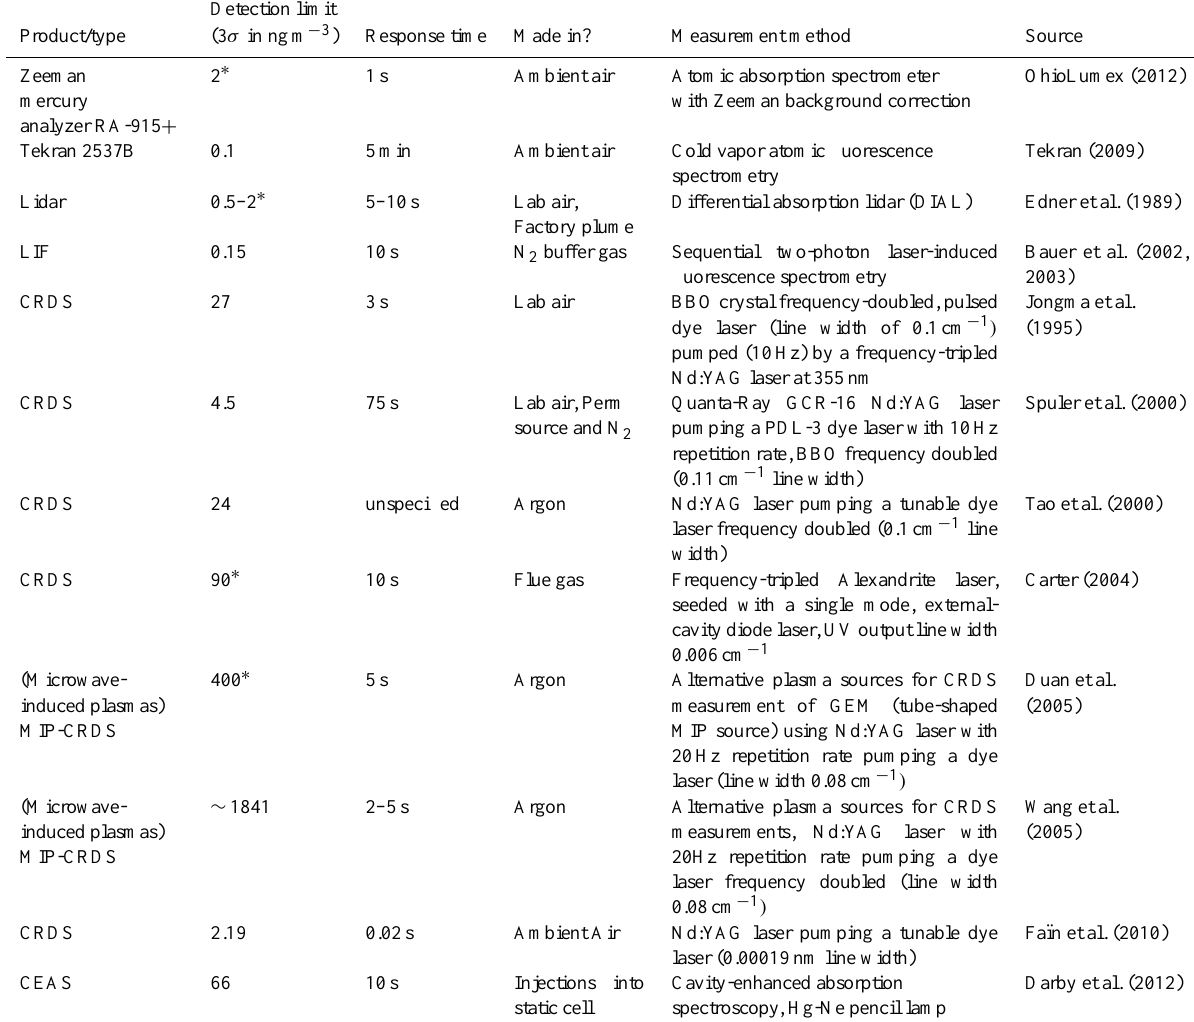
Table 1. Sensors used for detection of